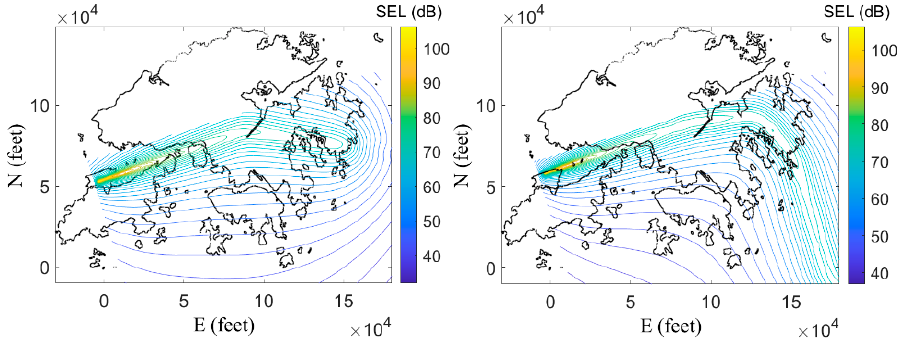
Figure 14. B777 aircraft approaching HKIA. Noise impact (SEL) generated by flight BA1(left) and BA2 (right) over Hong Kong city.